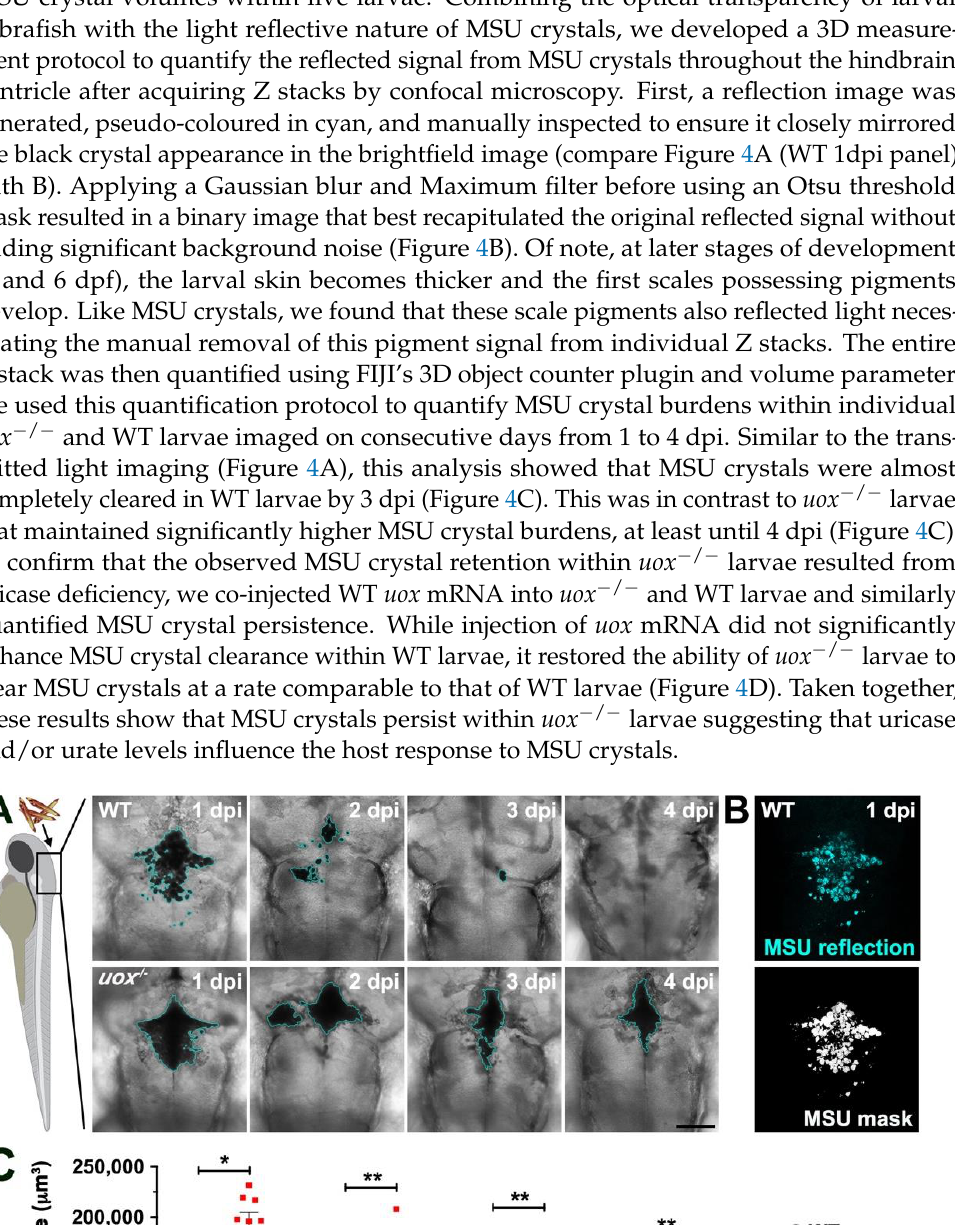
Figure 4. Microinjected MSU crystals persist in uox -/- larvae. ( A ) Representative confocal imaging (transmitted light views, Z-projections) of WT and uox -/- larvae at 1, 2, 3 and 4 days post-injection